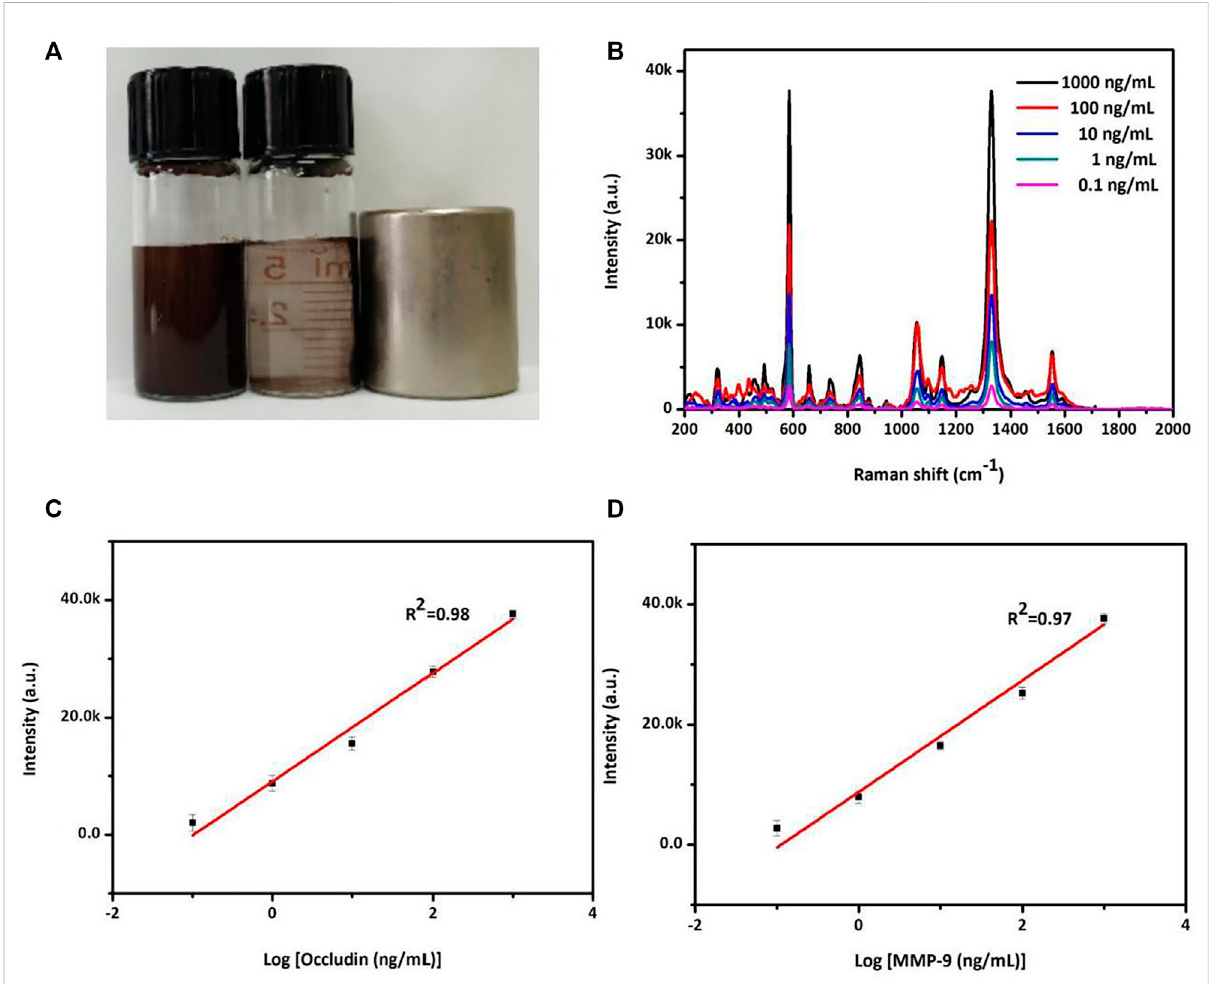
FIGURE 2 (A) Photograph of magnetic separation for the MNPs. (B) SERS spectra of NBA corresponding to the various concentrations of occludin and DTNB corresponding to the various concentrations of MMP-9 in a PBS solution. (C) Standard curve of the relationship between SERS intensity at 592 cm − 1 and the logarithm of occludin concentration from 0.1 to 1,000 ng/ml. (D) Standard curve of the relationship between SERS intensity at 1,332 cm − 1 and the logarithm of MMP-9 concentration from 0.1 to 1,000